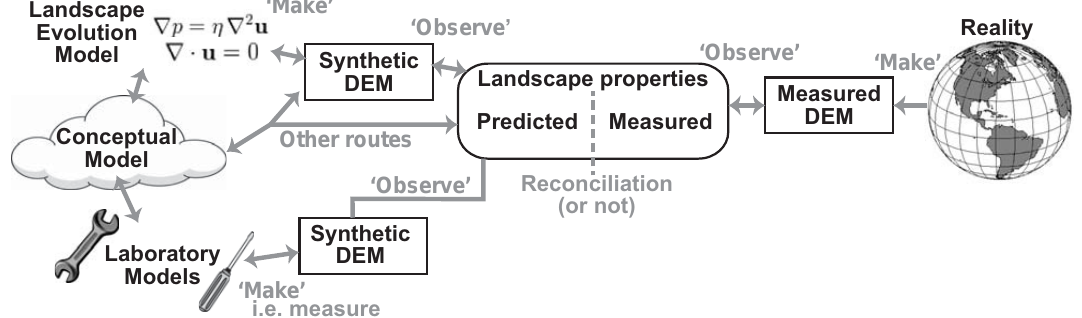
Figure 1. Illustration of the pathways and stages in reconciling geomorphological models with reality in order to understand the physical processes that sculpt planetary surfaces. Stages are in black, and tasks undertaken to move between them are in grey, with double-headed arrows indicating possible feedbacks. Synthetic DEMs may be created through various routes, and may be employed to add rigour to both the making of DEMs and the observing of them to derive landscape properties.